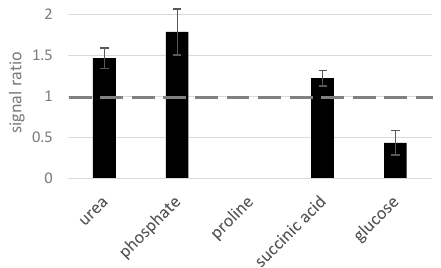
Figure 5. Proline (350 µM) recovery in presence of several compounds of different chemical natures in saturation (5 mM). Analyzed on an Agilent GC 6890.